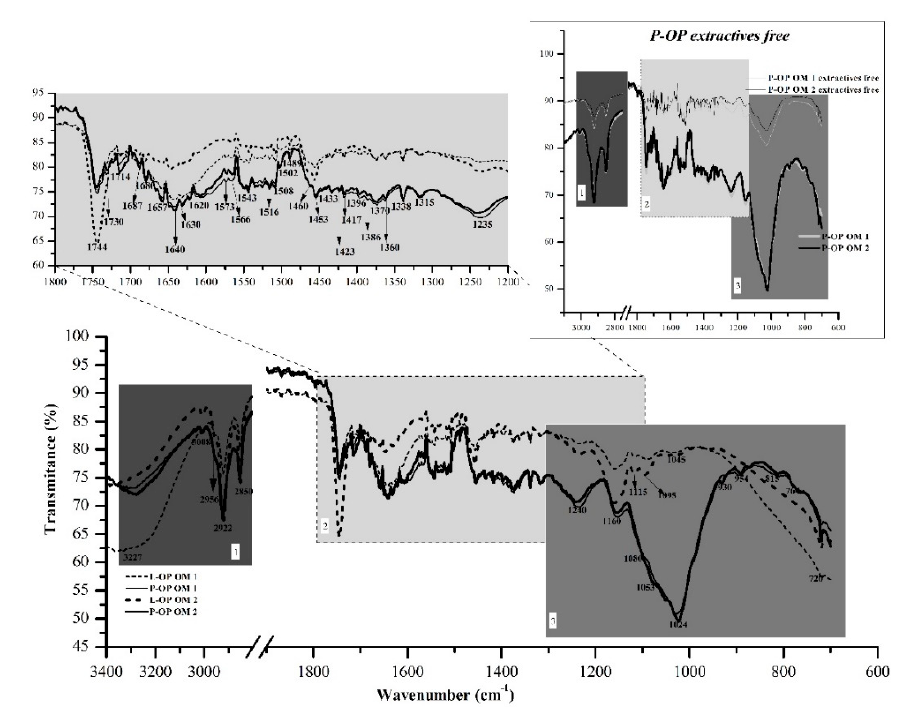
Figure 2. FTIR spectra of the liquid-rich fraction (L-OP) and pulp-rich fraction (P-OP) produced after the wet and dry fractionation process of crude olive pomace (C-OP). Abbreviations: C-OP—crude olive pomace, L-OP—liquid-rich fraction, P-OP—pulp-rich fraction.